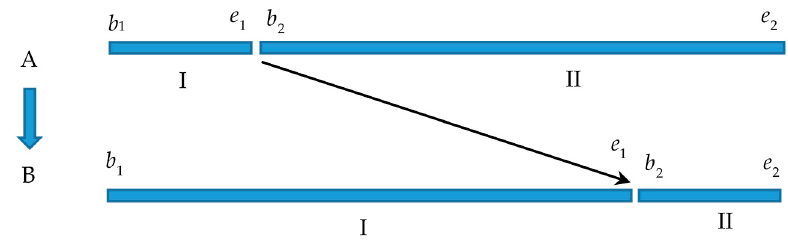
Figure 5. Basic process of model solving.